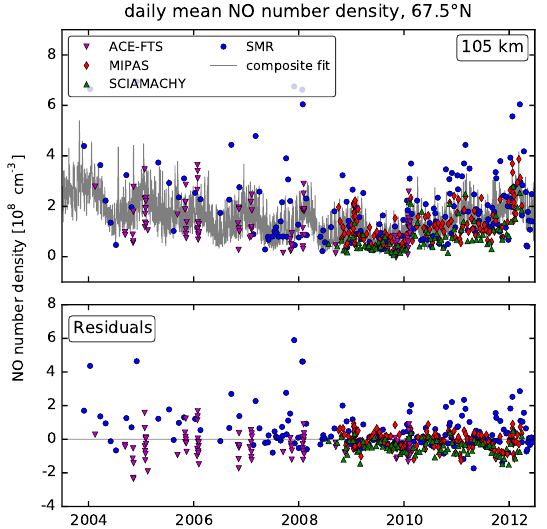
Figure 12. NO time series regression results at 67.5 ◦ N, 105km, as in Fig. 11.